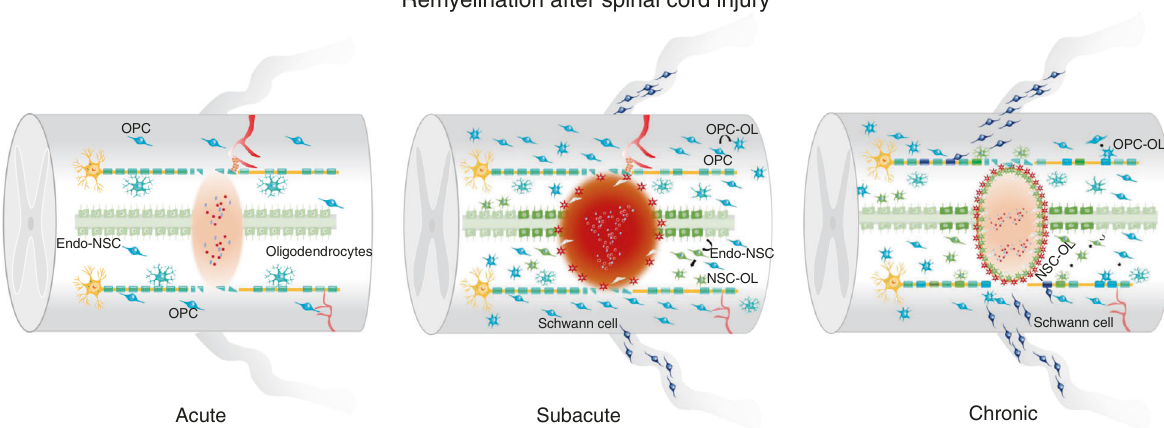
Fig. 4 Remyelination after SCI. This fi gure shows the changes in remyelination after SCI. In the acute phase of SCI, the number of oligodendrocytes is reduced, and the integrity of myelin is disrupted. In the subacute phase of SCI, OPCs are activated and begin to differentiate into new oligodendrocytes. Additionally, a small number of OPCs can differentiates into Schwann cells. endo-NSCs are activated, and some of them differentiate into oligodendrocytes. In the chronic phase of SCI, newborn oligodendrocytes form myelin around spared